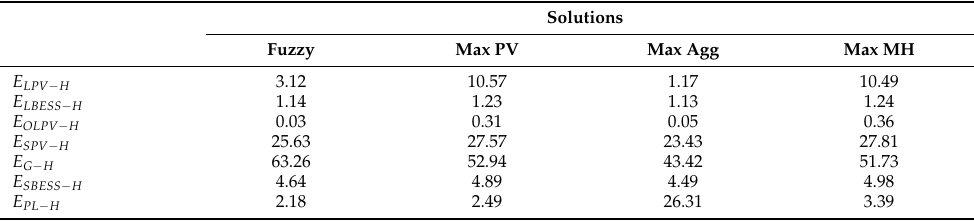
Table 10. Numerical values (in %) related to Figure 8.